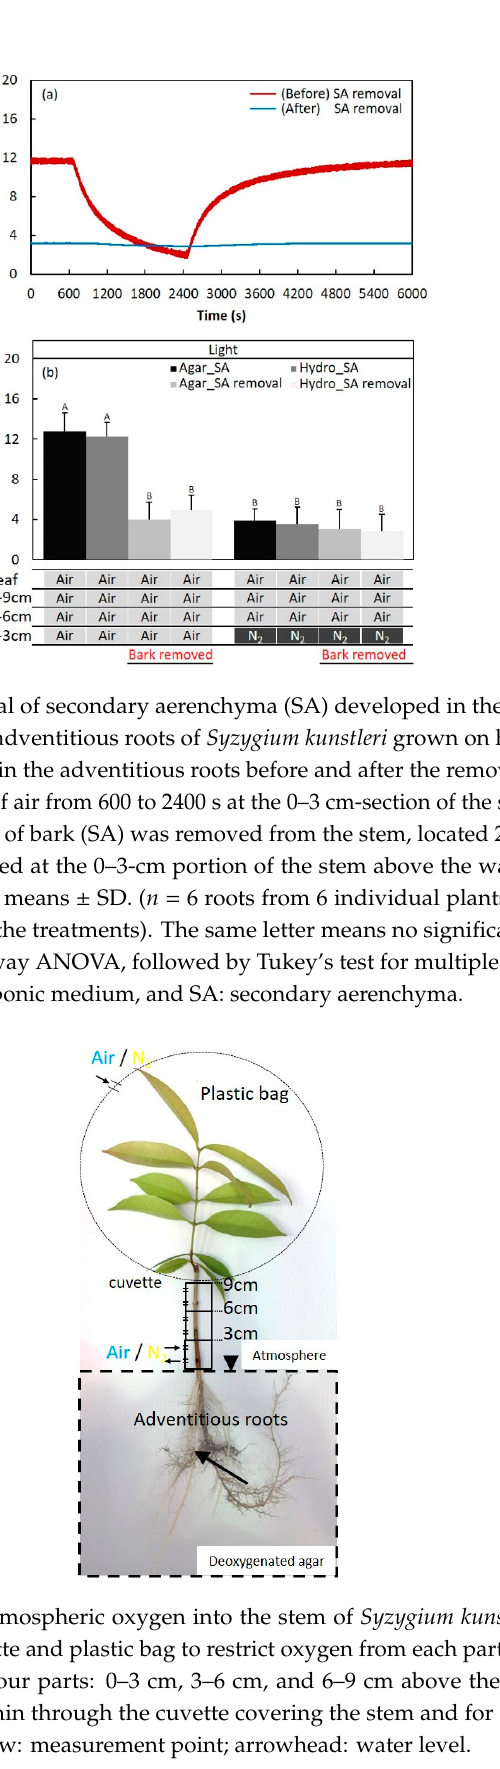
Figure 7. Entry portion of atmospheric oxygen in the stem of Syzygium kunstleri grown on hydroponic or agar media. Air or N 2 was injected into each part of the stem (0–3 cm, 3–6 cm, and 6–9 cm above the water